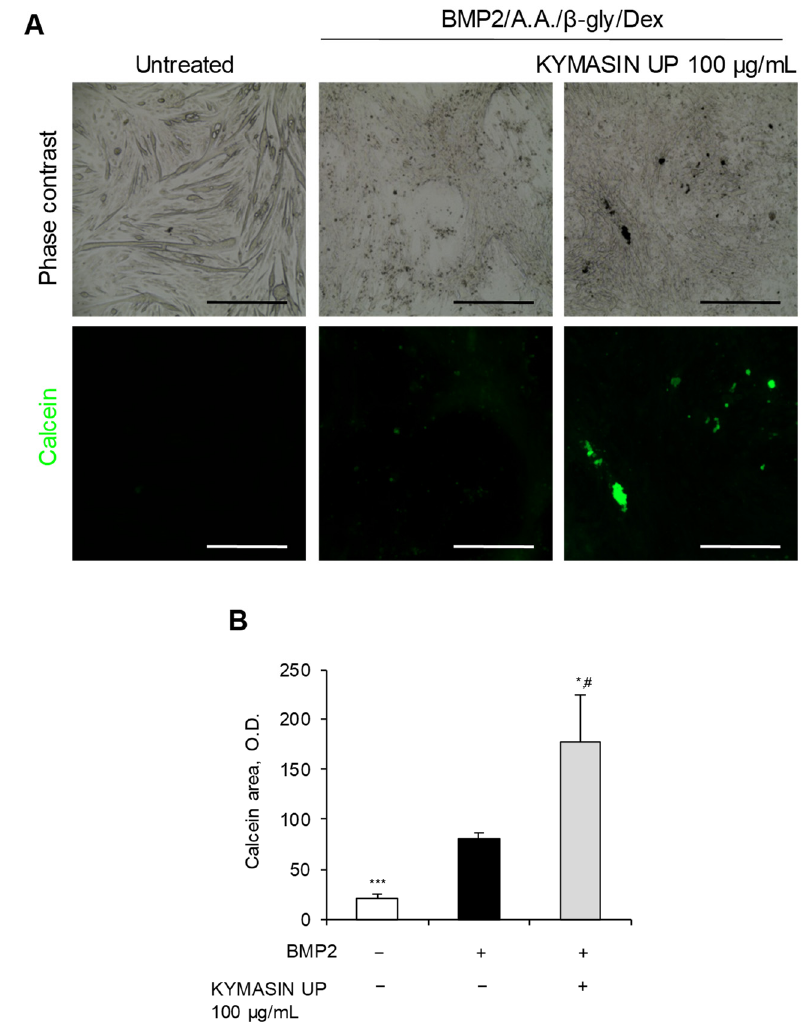
Figure 5. ( A , B ) C2C12 cells treated with BMP2 with or without KYMASIN UP (100 µg/mL) were cultured for 12 days in the presence of ascorbic acid (A.A.), β -glycerophosphate ( β -gly) and dexamethasone (Dex) to induce transdifferentiation and deposition of calcium nodules. ( A ) Phase contrast images were reported. Calcium nodule deposition was observed in fluorescence after calcein ( green ) staining. ( B ) The quantification of calcein-positive nodules was performed and reported as calcein optical density. Results are means ± standard deviation. Three independent experiments were performed. Statistical analysis was conducted using the two-tailed t -test. * p < 0.05, and *** p < 0.001, significantly different from BMP2. # p < 0.05, significantly different from untreated control. Reported are representative images. Scale bars ( A ), 400 µm.